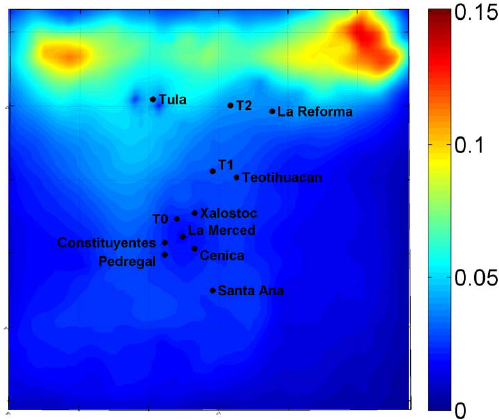
Fig. 6. Fractional contribution of locally-produced biogenic SOA to total OA at the ground level.